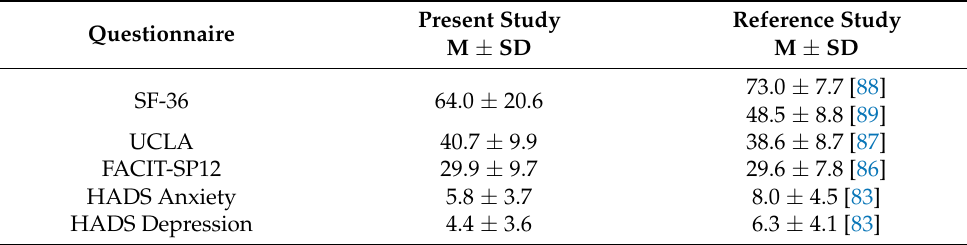
Table 3. Descriptive statistics of the questionnaires employed, both for the present study and for reference